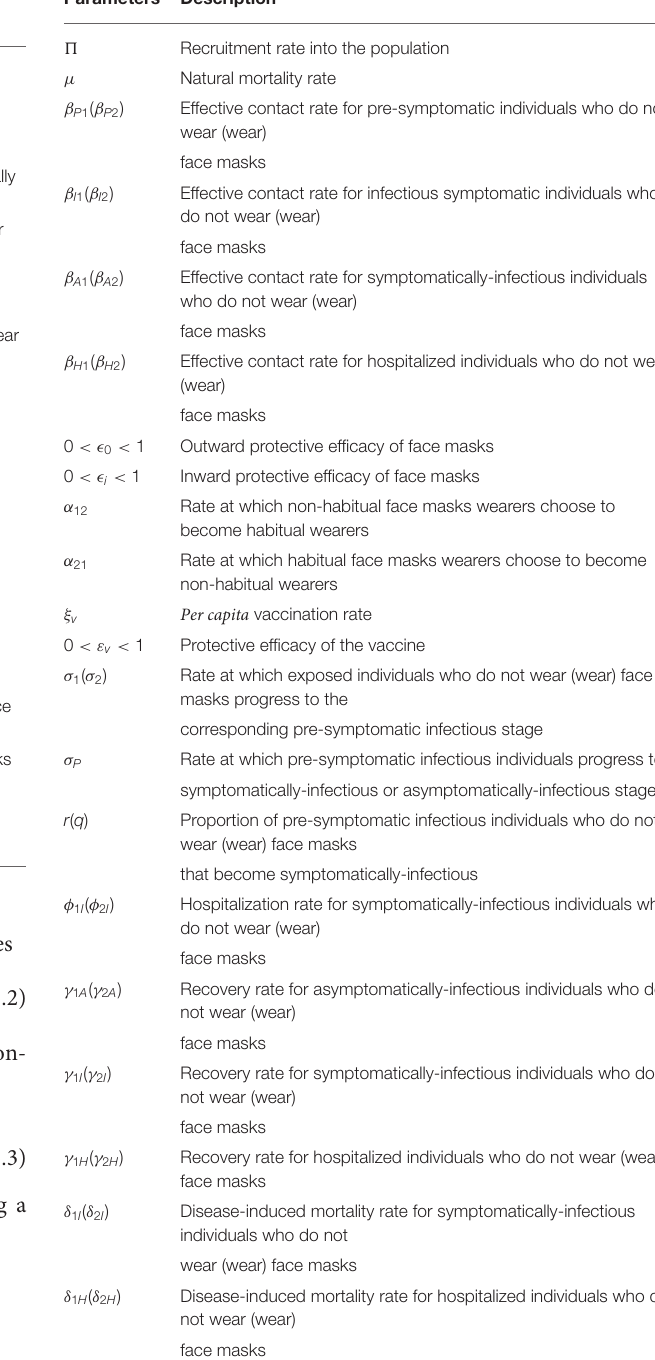
TABLE 2 | Description of the parameters of the model { (2.5),(2.6) } . Parameters